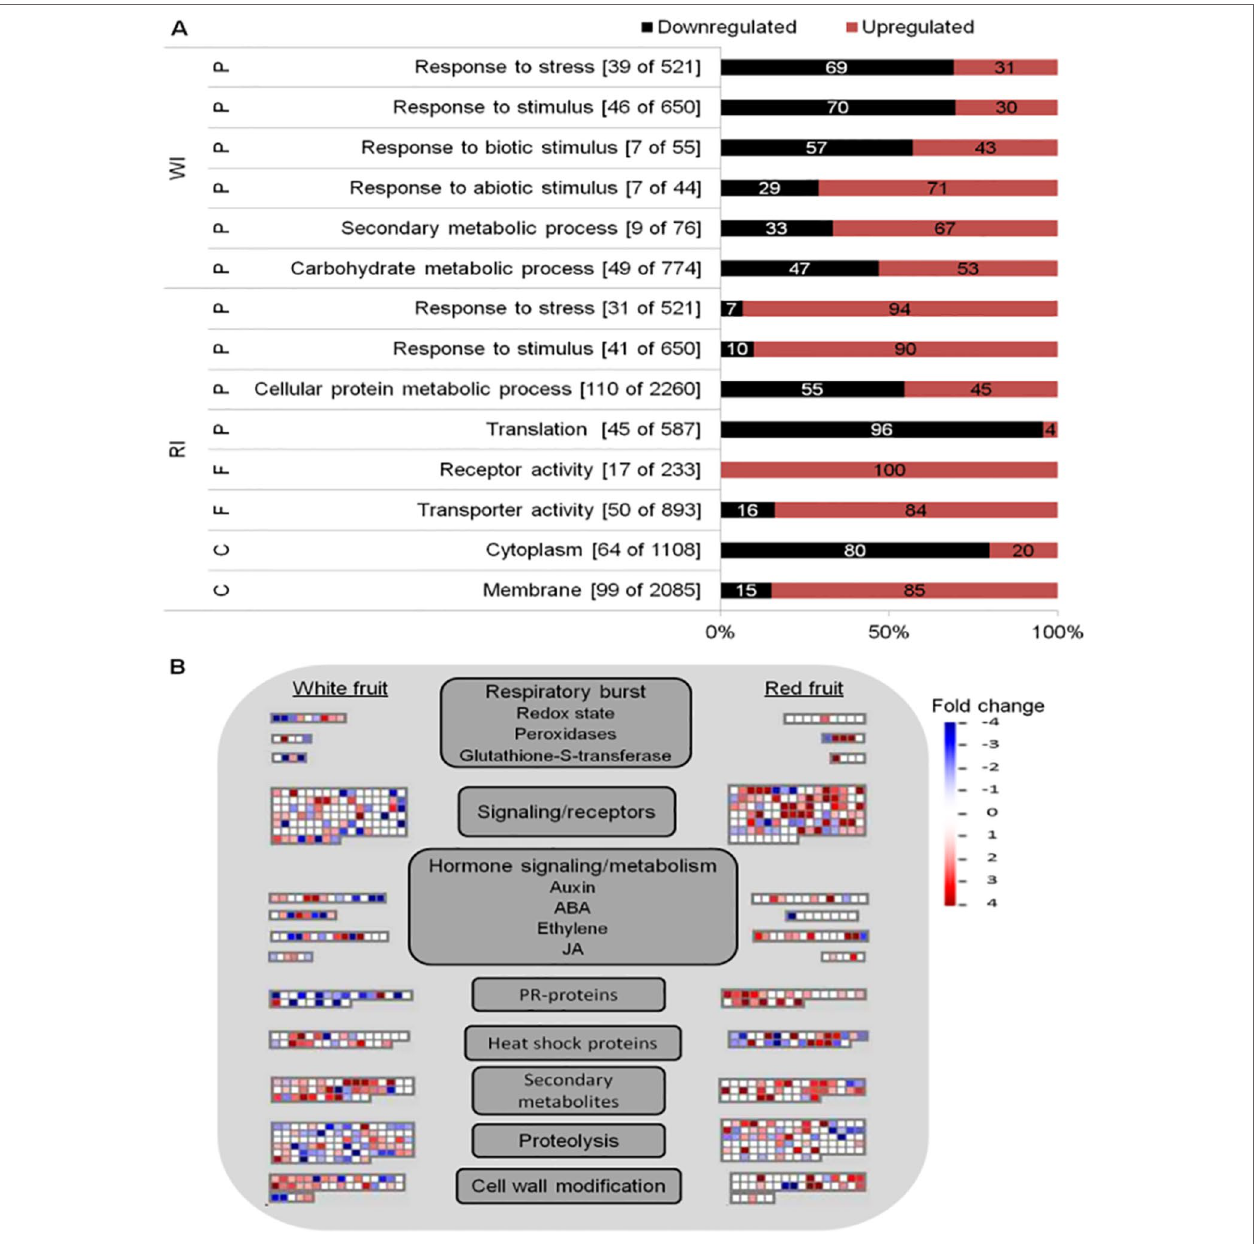
FIGURE 3 | Functional enrichment and biotic stress overview of the differentially expressed (DE) genes of Fragaria vesca in Botrytis cinerea inoculated white and red fruits, 24 h postinoculation. (A) Functionally enriched classes in the DE genes of white inoculated (WI) and red inoculated (RI) fruits, using AgriGO analysis tool. The number of DE genes out of the total F. vesca genes in each category is shown in parenthesis. The proportion of down- and upregulated genes within a category is represented by black and red bars, respectively. C, cellular component; F, molecular function; P, biological process. (B) Overview of biotic stress changes in infected fruits, visualized by MapMan. Up- and downregulated genes are shown in red and blue, respectively. The scale bar displays fold change values; fold change value “0” is given for genes which are not DE. ABA, abscisic acid; JA, jasmonic